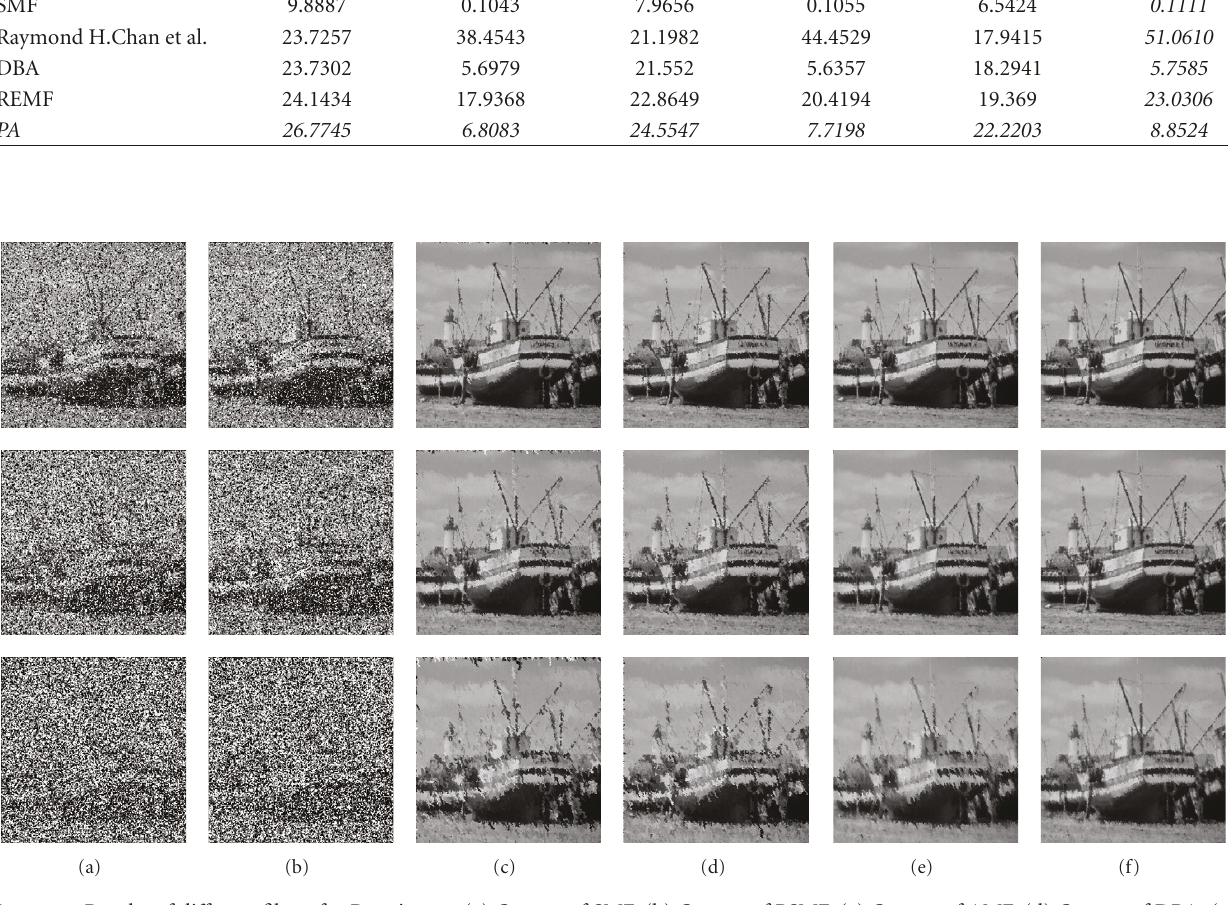
Figure 5: R esults of di ff erent filters for Boat image. (a) Output of SMF. (b) Output of PSMF. (c) Output of AMF. (d) Output of DBA. (e) Output of REMF. (f) Output of PA. Row 1–Row 3 show processed results of various filters for Boat.gif image corrupted by 70%, 80%, and 90% noise